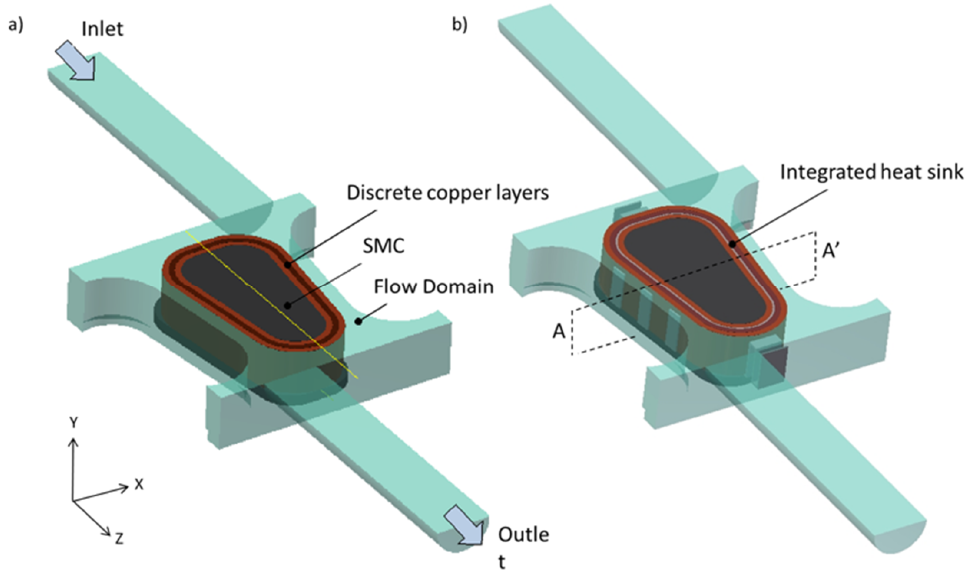
Figure 4. Example of the comparison between ( a ) the traditional pole piece and ( b ) the new construction with heat sink integrated within the windings. Table 1. Variation of coolant properties with temperature T, ◦ C.